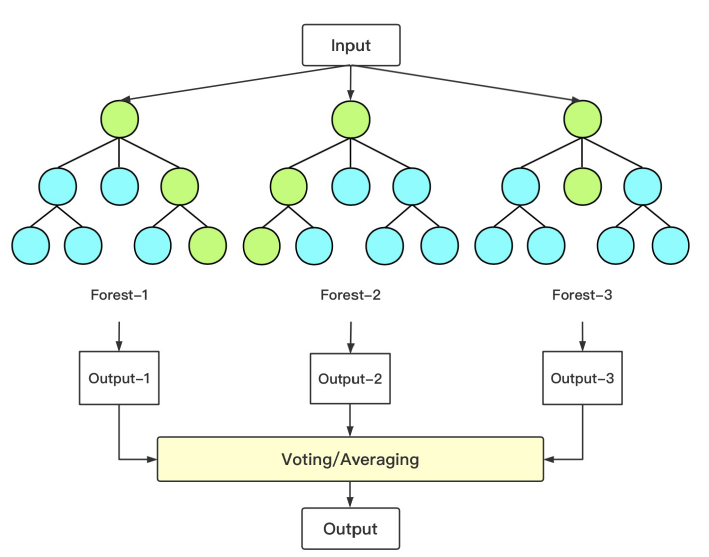
Figure 3. The structure of the random forest model. To return a new object from an input vector, put the input vector down each of the trees in the forest. Each tree gives a classification or a regression. The forest chooses the classification having the most votes (over all the trees in the forest), or it averages the prediction results of multiple internal decision